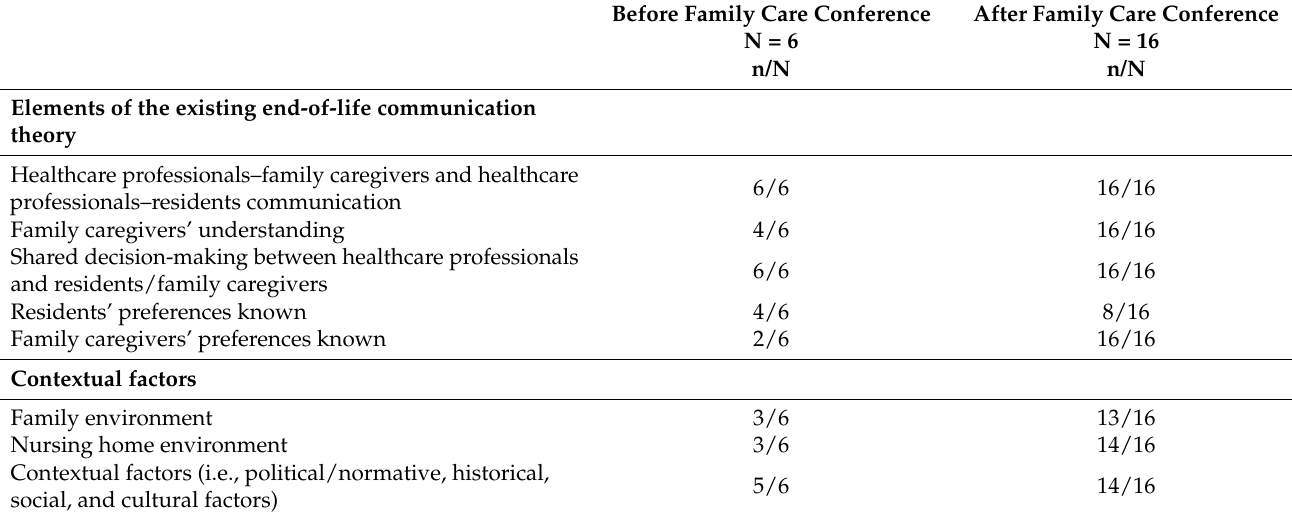
Table 4. Elements of the Existing End-of-Life Communication Theory and Contextual Factors that Emerged in the Interviews Before and After the Family Care